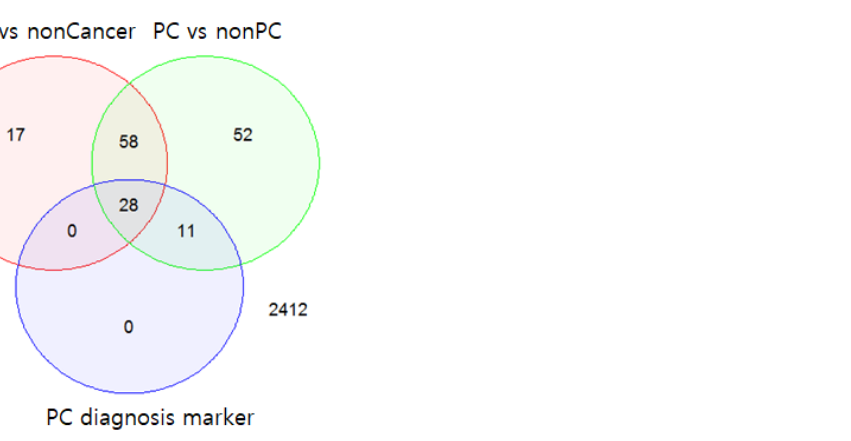
Figure 3. Venn diagram of the differentially expressed miRNAs and 39 selected diagnostic markers. The top 39 miRNAs included 28 miRNAs that were differentially expressed between pancreatic cancer (PC) samples and non-cancer samples (false discovery rate (FDR) < 0.05) and 11 miRNAs that were differentially expressed only between the PC and non-PC samples (FDR < 0.05).